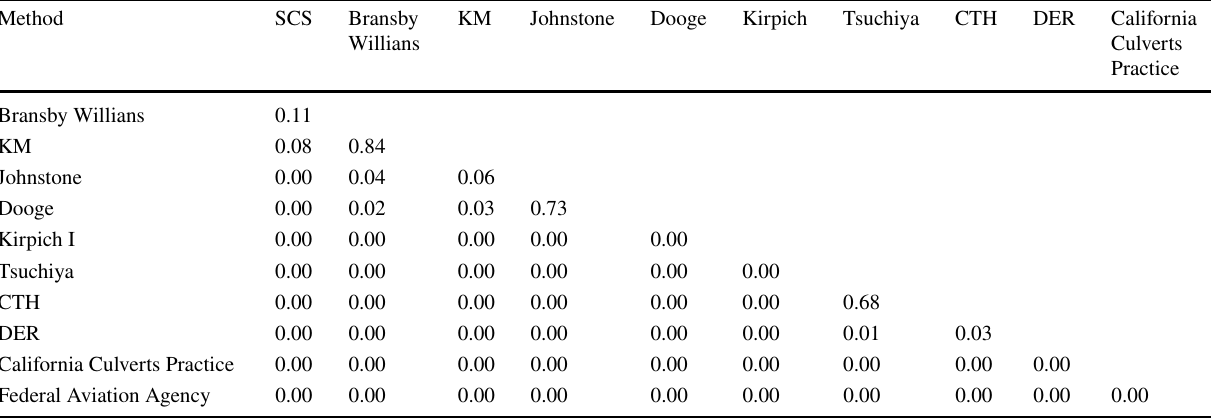
Table 6 Correlation between NC and Recurrence Period